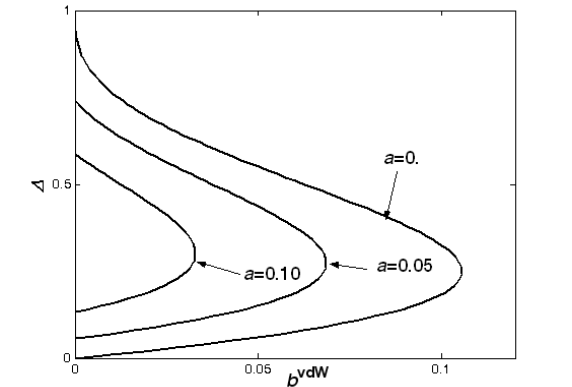
Figure 8. Bifurcation diagram: variation of equilibrium points with parameter vdW b for different a .